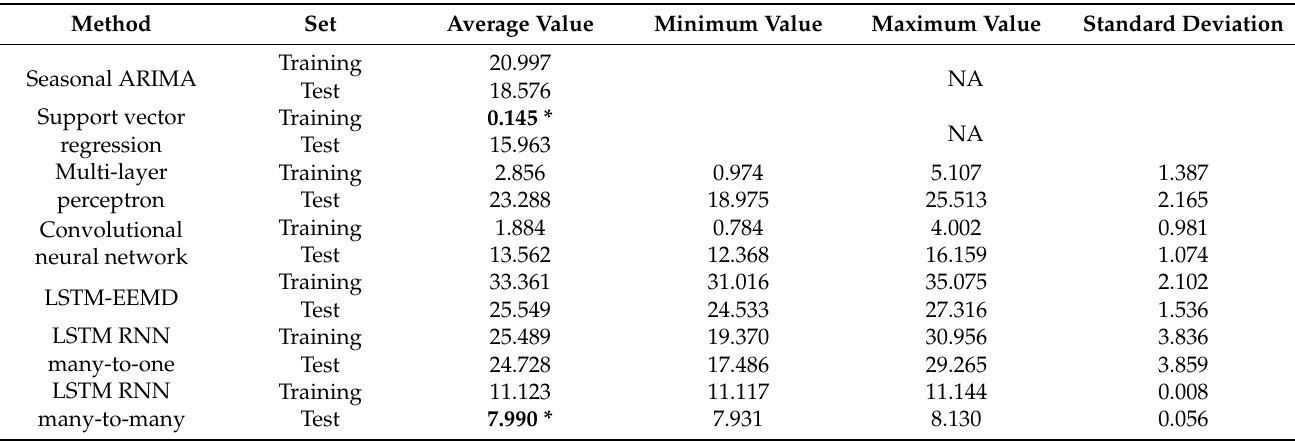
Table 6. Mean absolute error for actual